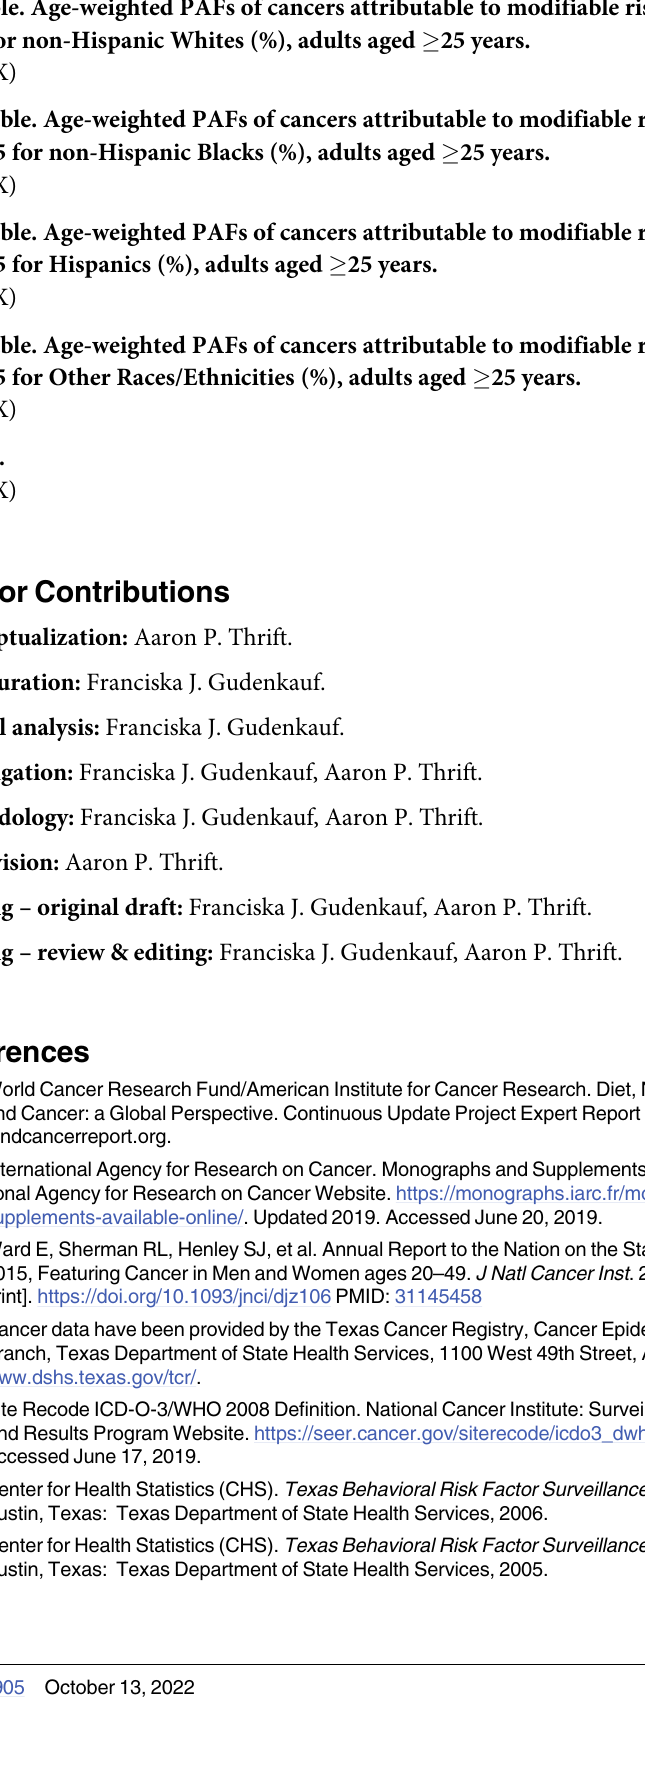
S9 Table. Age-weighted PAFs of cancers attributable to modifiable risk factors in Texas in 2015 for non-Hispanic Whites (%), adults aged � 25 years. S10 Table. Age-weighted PAFs of cancers attributable to modifiable risk factors in Texas in 2015 for non-Hispanic Blacks (%), adults aged � 25 years. S11 Table. Age-weighted PAFs of cancers attributable to modifiable risk factors in Texas in 2015 for Hispanics (%), adults aged � 25 years. S12 Table. Age-weighted PAFs of cancers attributable to modifiable risk factors in Texas in 2015 for Other Races/Ethnicities (%), adults aged � 25